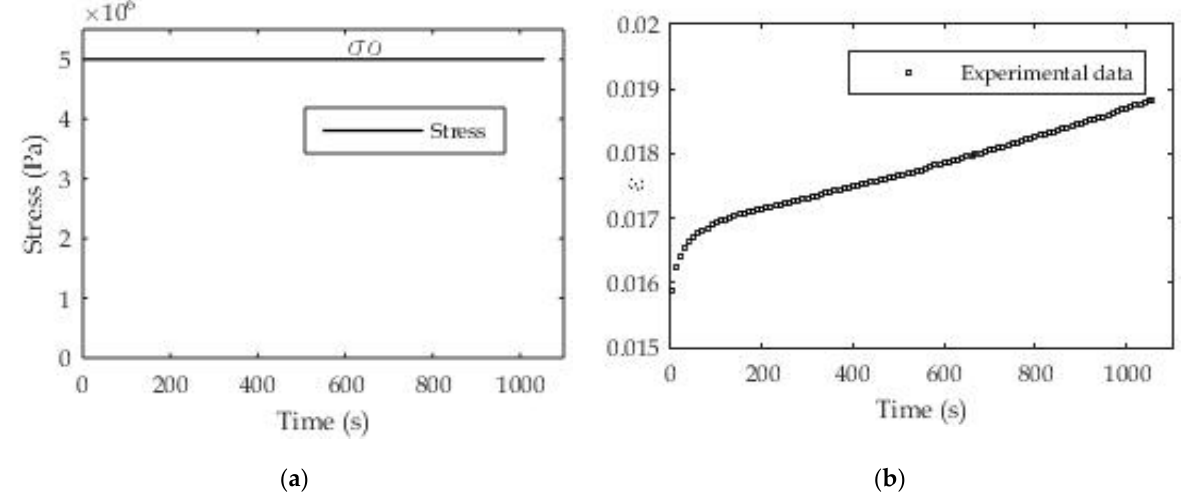
Figure 6. ( a ) Creep test with constant load ( σ o = 5 MPa); ( b ) experimental results for strain ε (t).